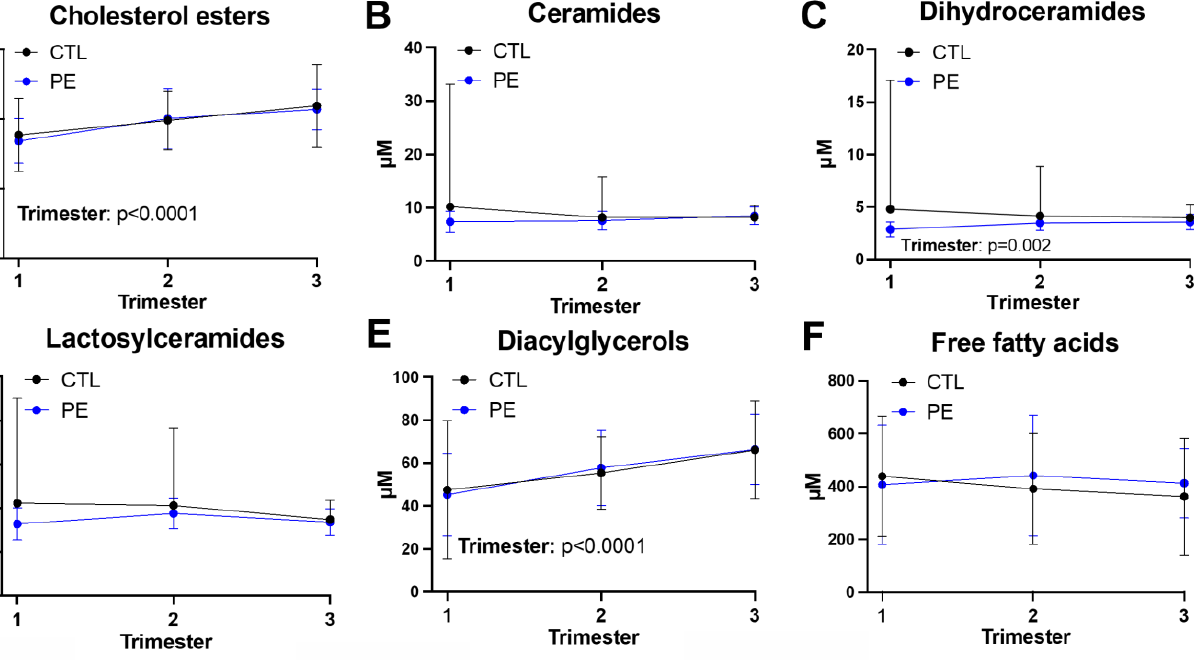
Figure 1. Changes in broad lipid classes during pregnancy. ( A – L ) Plasma concentrations of broad lipid classes at each trimester in uncomplicated (CTL) and preeclampsia (PE) pregnancies. Lipid class concentrations were calculated by summing the concentrations of all individual lipid species, measured by mass spectrometry, within a class. Significant sources of variation were determined by linear mixed effects modeling and are indicated in the lower left of each panel. Šídák’s multiple comparisons test was used to compare CTL and PE groups at each trimester. Error bars represent SD. 2.8. Lipidomic Statistical Analysis 2.8.1. Pre-Processing of Lipidomics Data All lipidomic statistical analyses were performed using Prism (Graphpad) and vari- ous packages in R. To prepare data for statistical analysis, we handled missing values with